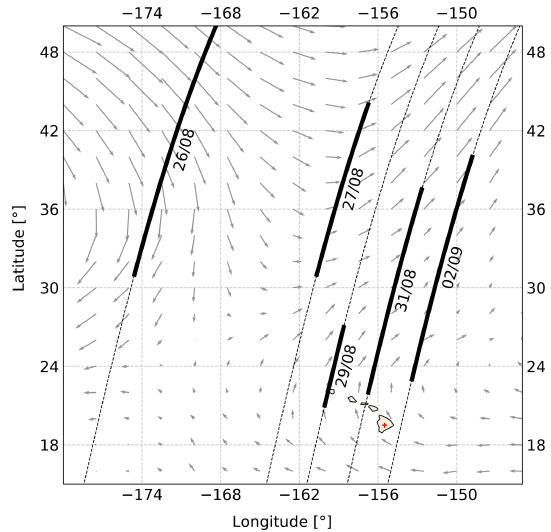
Figure 3. Nighttime CALIOP tracks (dashed black) in the MLO (red cross) area analyzed as part of the PyroCb plume tracking. The spatial extension of the stratospheric aerosol plumes detected during the overpasses are highlighted with thick black lines. MERRA-2 winds at 100hPa are also shown (black